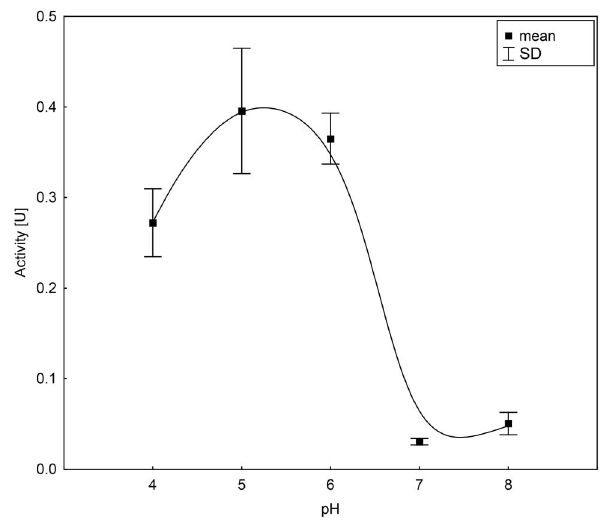
Figure 2. Mean chitinolytic activity in the stomach samples of Pipistrellus pipistrellus at different pH values. Curve fitted by distance-weighted least square smoothing procedure.